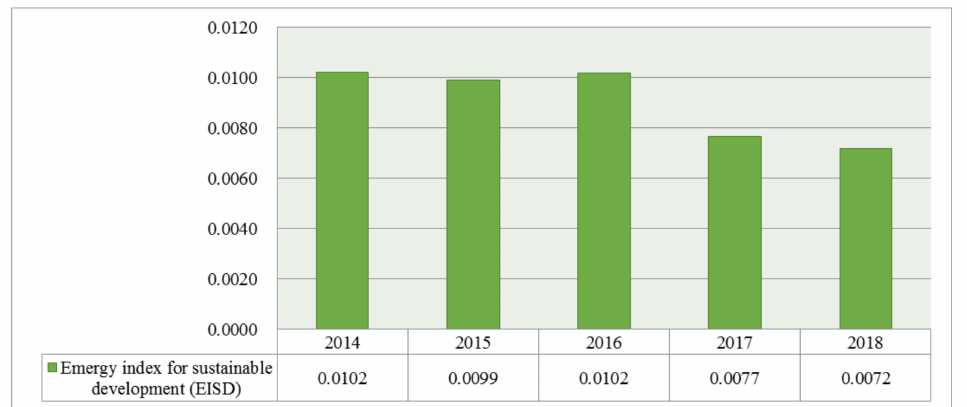
Figure 5. Analysis of the sustainable development